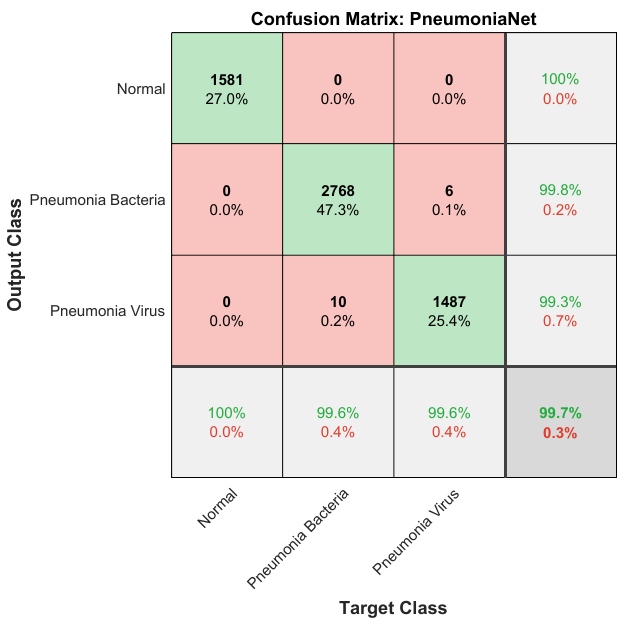
Figure 5. Average Accuracy against epoch ( A ) and average cross-entropy loss against epoch ( B ) for all cross-validation folds.